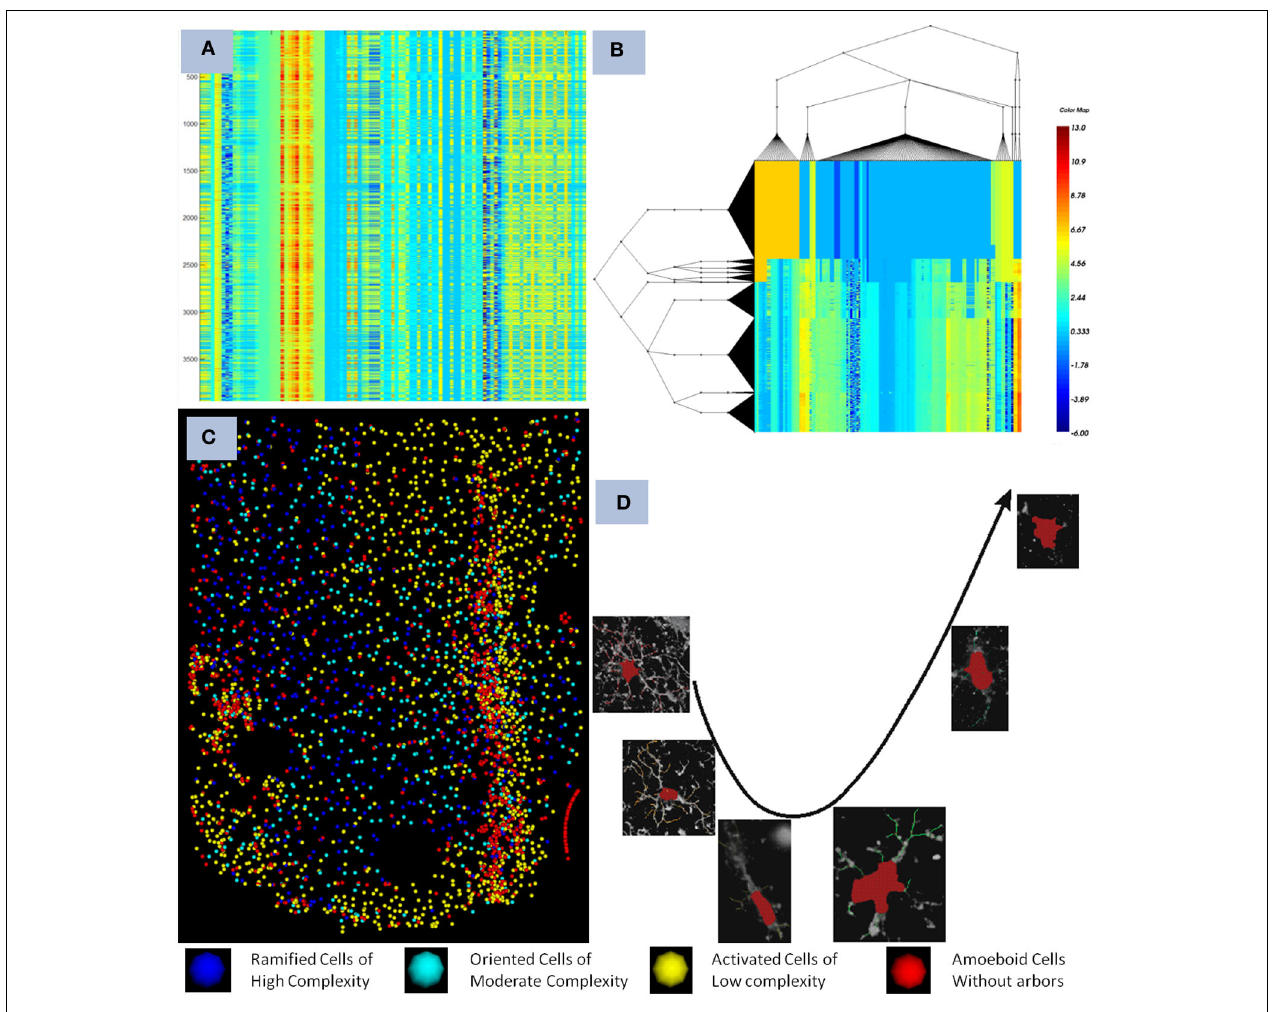
FIGURE 4 | Illustrates the final result obtained after the pipeline was run on a dataset containing a device. (A) show the features computed for each microglia as seen in the heat map before clustering, each row corresponds to a cell, and each colum to a feature, (B,C) shows the co-clustering obtained displayed as a heat map and the corresponding